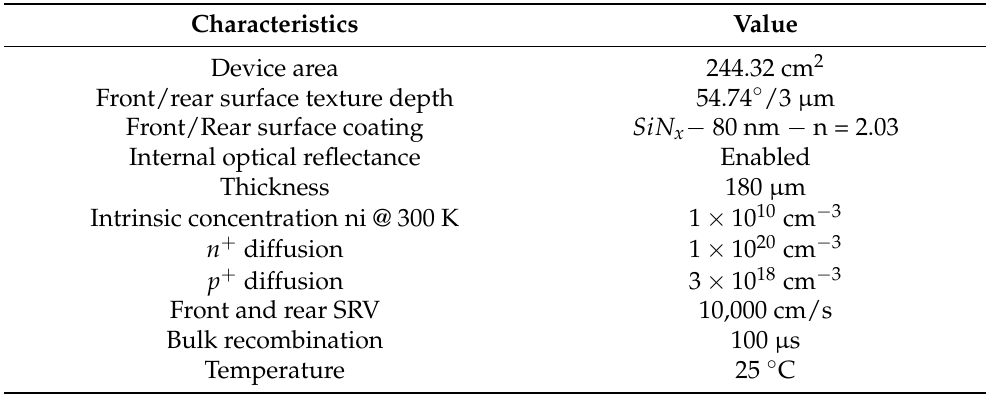
Table 1. Unique characteristics of each appliance used in the simulations